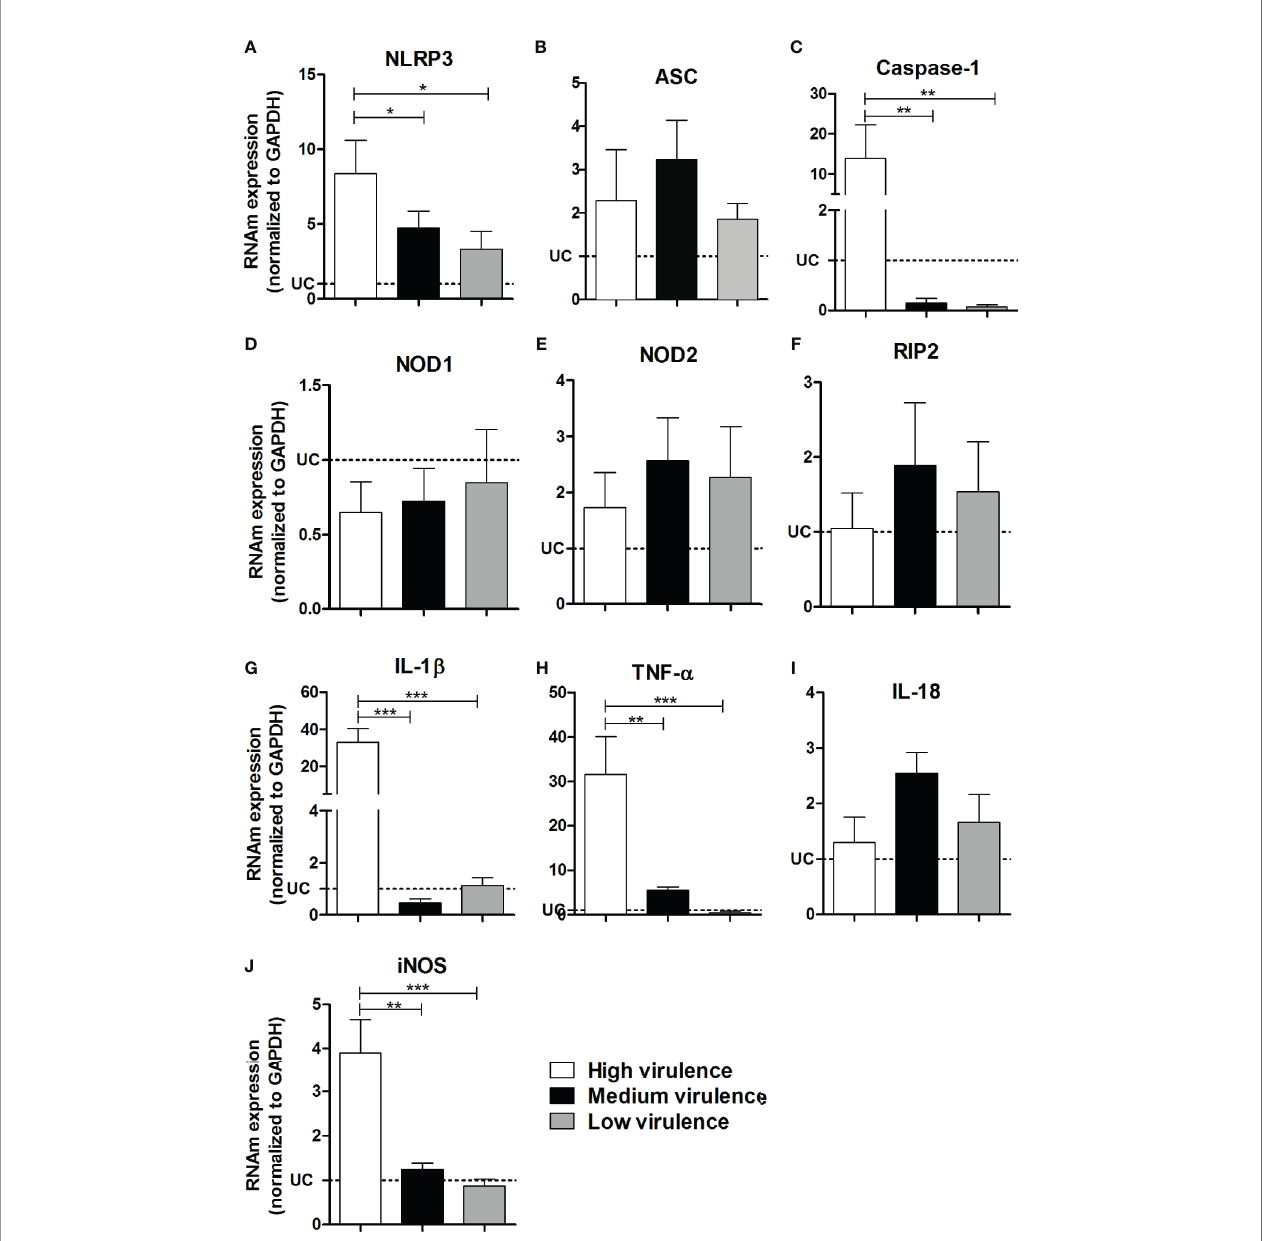
FIGURE 5 | Virulence of strains is correlated with NLRP-3, caspase-1, IL-1 b , TNF- a , and iNOS increase in heart from mice. The mRNA expression levels of NLRP3 (A) , ASC (B) , caspase-1 (C) , NOD1 (D) , NOD2 (E) , RIP2 (F) , IL-1 b (G) , TNF- a (H) , IL-18 (I) , and iNOS (J) were determined by real-time PCR in the heart from Swiss mice infected by the intraperitoneal route with 1 × 104 blood trypomastigote forms of Trypanosoma cruzi strains that showed low (AM64 + 3253) (n = 10), medium (PL1.10.14 + CL) (n = 10), and high (Colombian + Y) (n = 10) virulence. The expression levels were normalized to the expression level of GAPDH. The results are expressed as the means ± standard errors. * p < 0.05; ** p < 0.01; *** p < 0.001. UC, uninfected control mice (n =